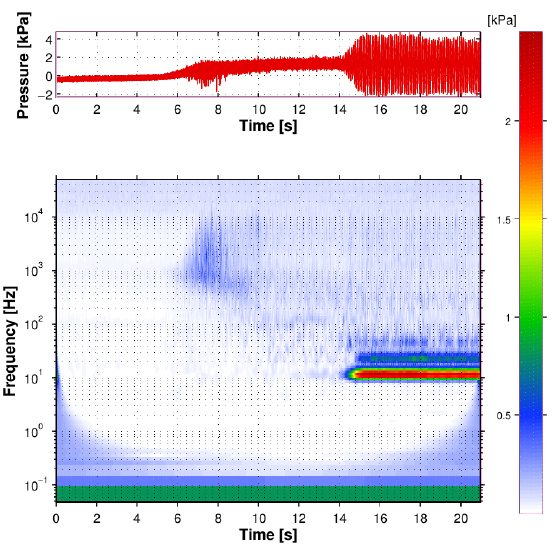
Figure 7: Pressure signal at gauge p imp 1 and its CWT scalogram.